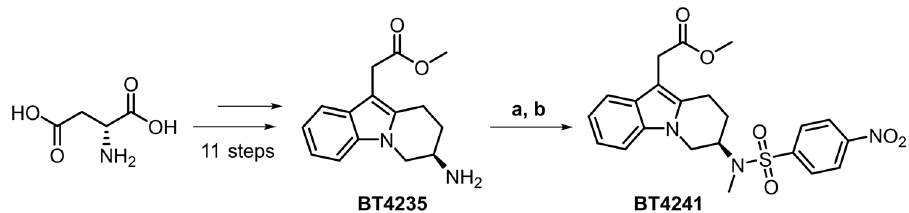
Figure 1. Chiral pool approach to access key target precursor BT4241 starting from D-aspartic acid. ( a ) 4-nitrobenzenesulfonyl chloride (2.0 equiv.), Et3N (3.1 equiv.), THF, rt, 12 h, 62%. ( b ) MeI (1.2 equiv.), NaHMDS (1.5 equiv.), DMF/THF, − 40 °C, 3 h, 61%.